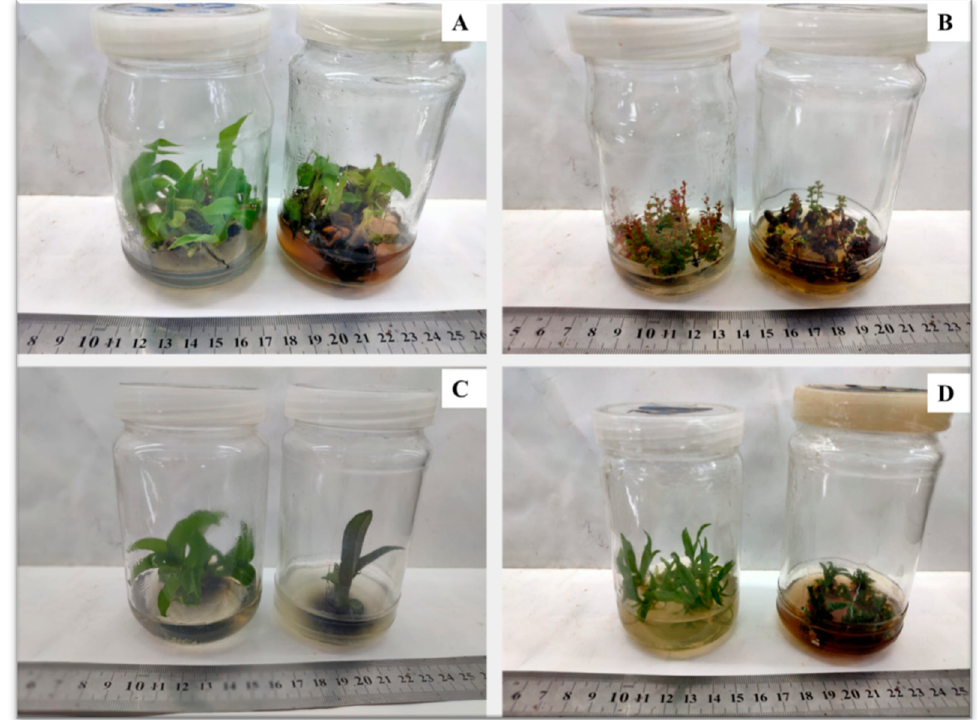
Figure 5. The symptoms of browning at the stage of shoot multiplication of in vitro plantlets. Left jar = normal plant, right jar = browned plant. Banana plant ( Musa sp.) ( A ), blueberry plant ( Vaccinium corymbosum L.) ( B ), Phalaenopsis sp. ( C ), and Cattleya sp. ( D ).